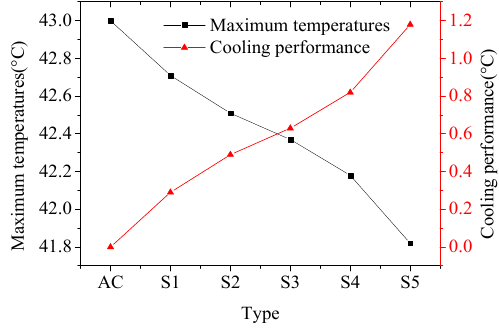
Figure 11. Cooling performance of the structures.